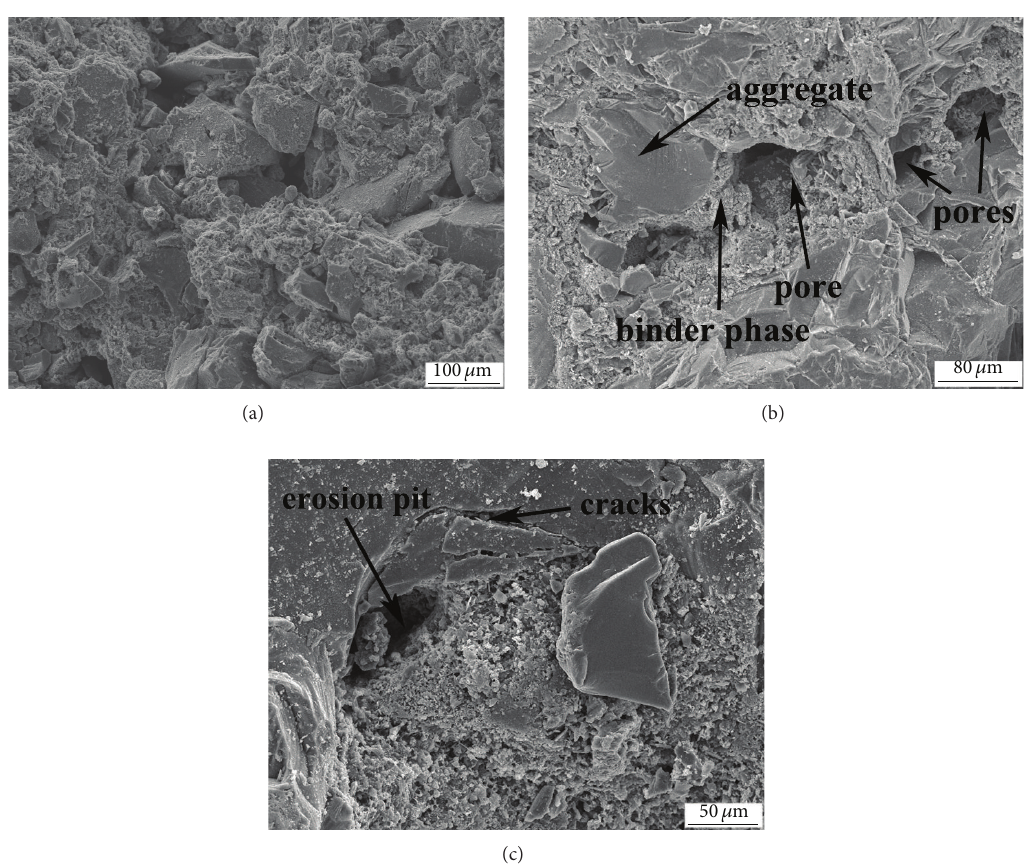
Figure 4: Erosion morphologies of the aggregate and binder phases in the samples: (a) sample M1 (no silicon added) eroded at 25 ∘ C; (b) sample M4 (12% silicon added) eroded at 25 ∘ C; (c) sample M4 (12% silicon added) eroded at 800 ∘